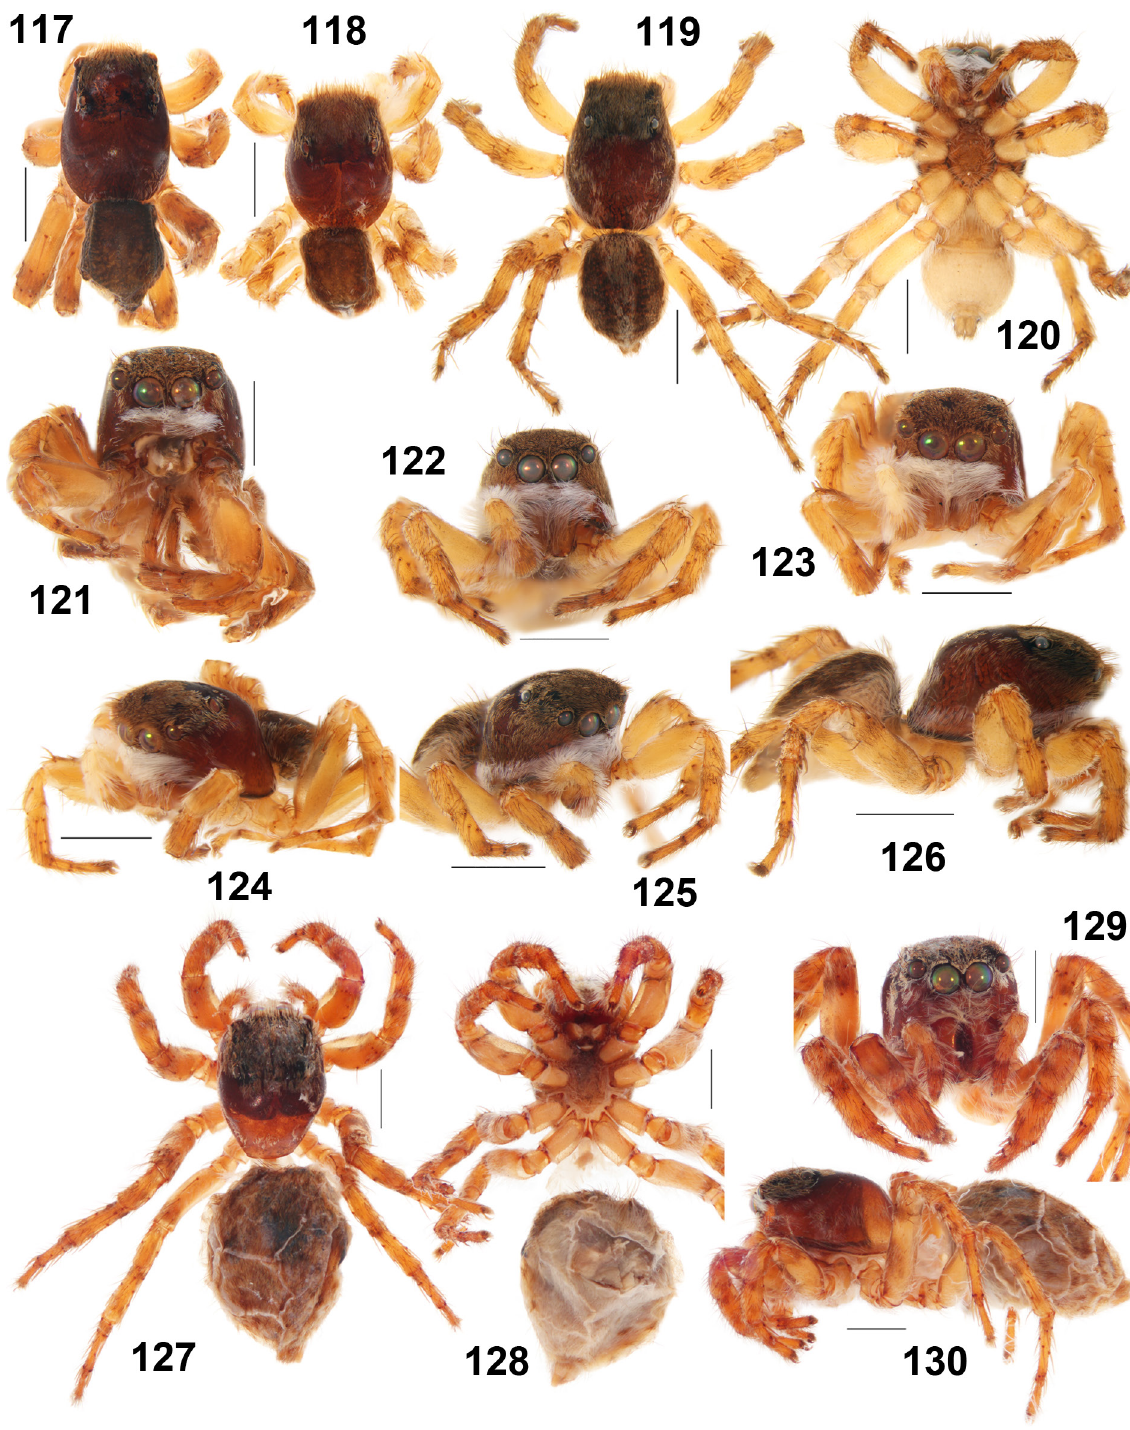
Figs 117–130. Manzuma lympha (Próchniewicz & Heçiak, 1994) gen. et comb. nov., holotype (117, 121), paratype (118, 123–124), ♂ from Masai Mara (SMF 69776) (119–120, 122, 125–126) and ♀ from type locality (127–130), general appearance. Scale bars: 1